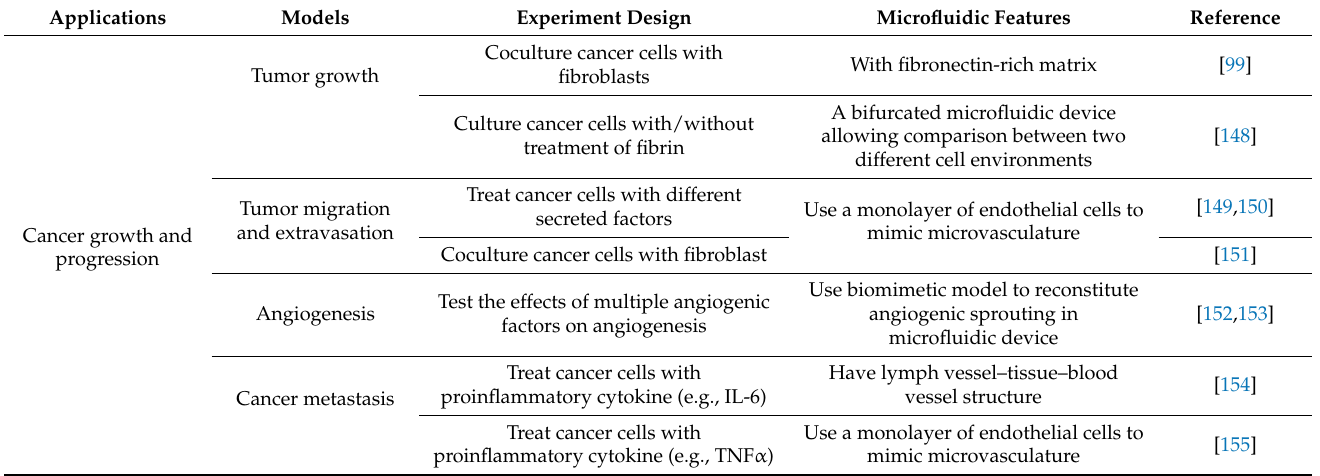
Figure 1. Microfluidic devices in modeling tumor growth and progression, TME, and cancer–immunity cycle, as well as clinical-related applications. Table 2. Microfluidic technology in cancer modeling.